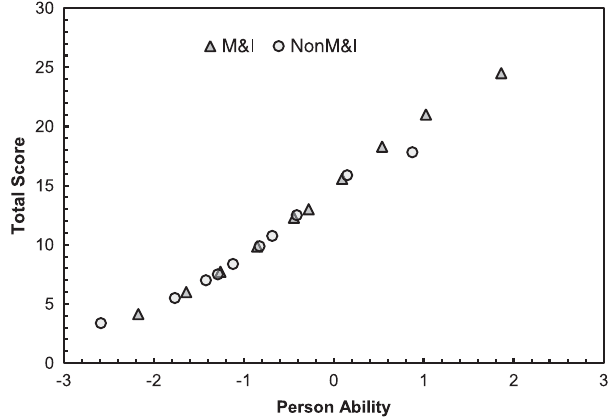
FIG. 6. BEMA test characteristic curves (showing total scores as a function of person ability estimates) based on the data from the traditional and M&I courses,